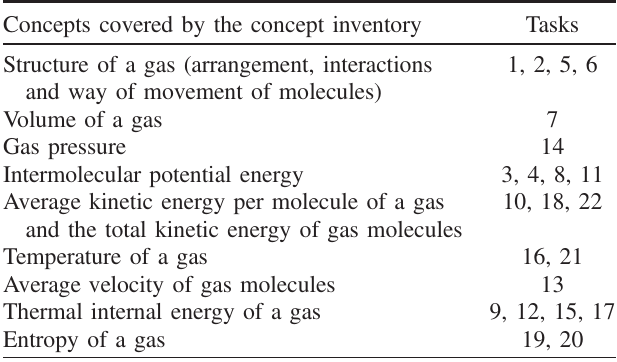
TABLE IV. Conceptual coverage of the kinetic molecular theory of gases (KMTG) concept